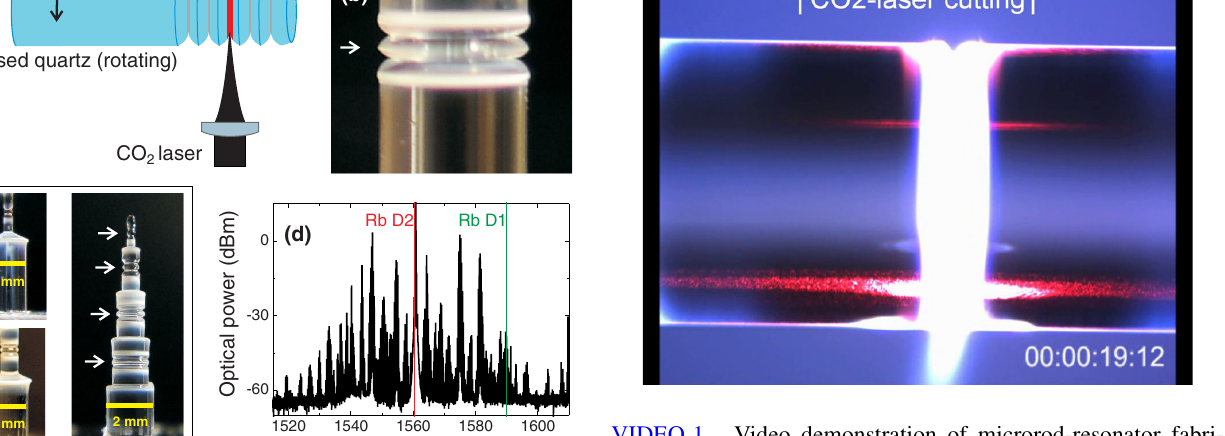
VIDEO 1. Video demonstration of microrod-resonator fabri- laser machining. A 2-mm-diameter fused- cation using CO 2 quartz rod is rotated with a spindle, and it is shaped and polished FIG. 1. Fabrication of fused-quartz microrod resonators by use by the laser. The laser beam translates between two axial -laser machining. (a) A rotating fused-quartz rod is of CO 2 positions along the rod by adjusting the focus lens. Total fabri- laser that selectively removes illuminated with a focused CO 2 cation time is < 1 min . material. By applying the laser at different positions along the rod’s axis, a microresonator is produced. (b) Image of a microrod with Q ¼ 5 (cid:1) 10 8 , 2-mm diameter, and approximately 100 - (cid:1) m mode cross-sectional diameter. (c) Fabrication of resonators with variable diameter. Starting at top left and counting clockwise, the resonator diameters are 0.58 mm, 0.36 mm, 0.71 mm, 1.2 mm, 1.5 mm, and 1.0 mm. (d) Optical spectrum from the device in (b), which has a modulated envelope characteristic of parametric combs [14,18,36]. The span of this comb is sufficient to access the D1 and D2 transitions of atomic Rb, following second- harmonic generation.